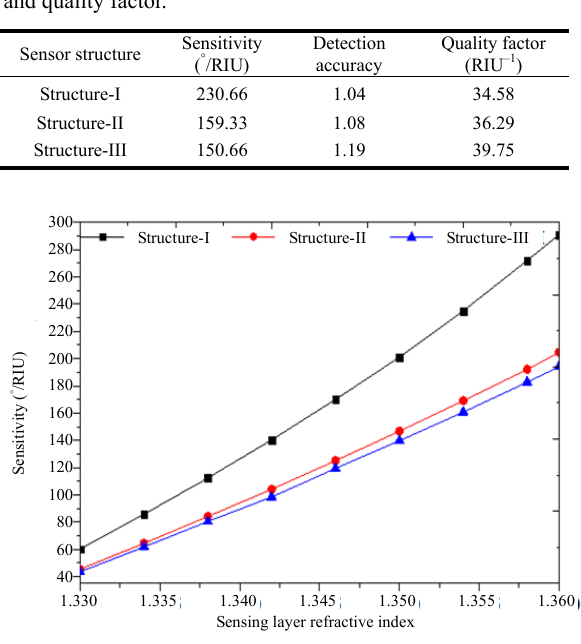
Fig. 3 Variation of sensitivity as a function of the sensing layer’ refractive indices for structure-I, structure-II, and structure-III.